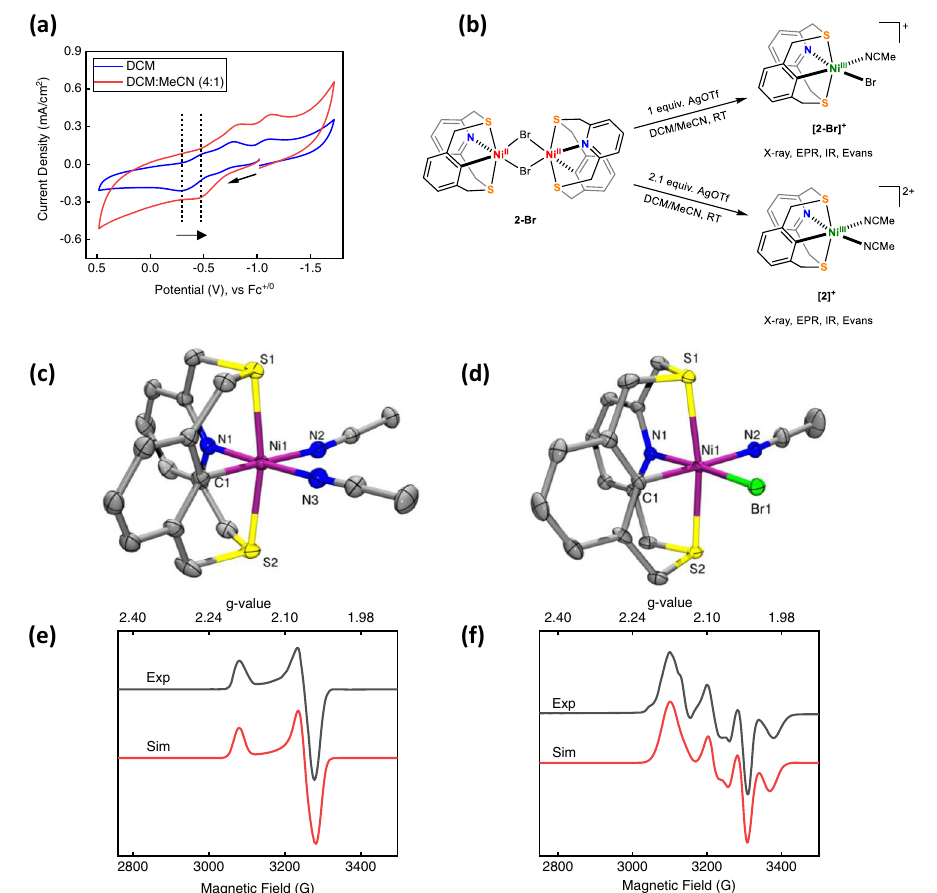
Fig.5|SynthesisandcharacterizationofC – HactivatedNi III complexes.a Cyclic voltammogram of [2-Br] in dichloromethane (blue) and 1:4 acetonitrile:di- potential. b Synthesisof chloromethane(red)showingacathodicshiftinthe E Ni II = III Ni III complexes discussed in the text, starting from [2-Br] , using Ag + as oxidant. c , d ORTEP representations (50% probability ellipsoids) for [ 2] + and [2-Br] + ( c ) Selected bond distances for [2] + : Ni1 – S1: 2.3431(5), Ni1 – S2: 2.3556(5), Ni1 –